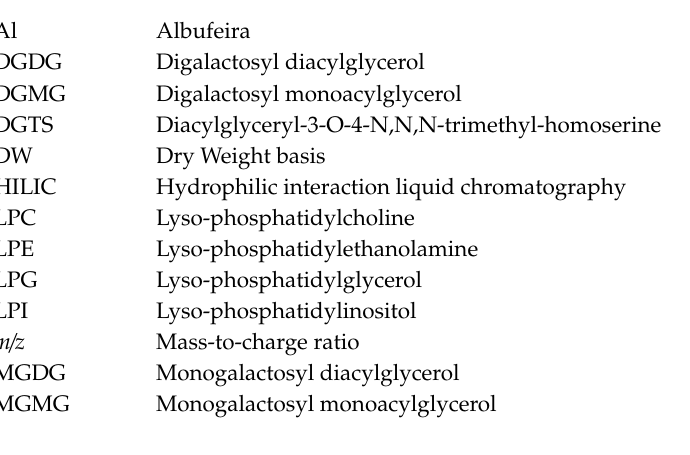
Figure S1: title, Table S1: title, Video S1: